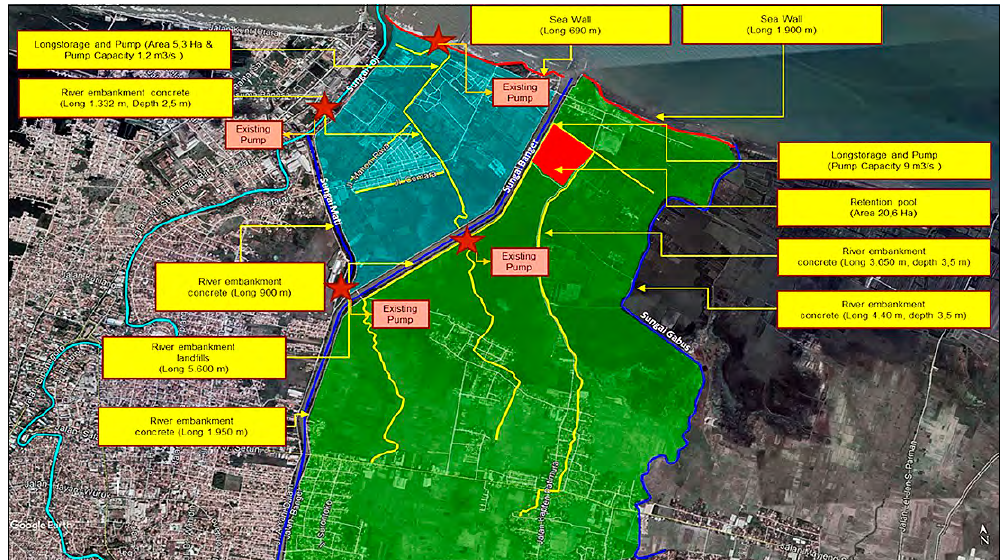
Figure 18. Design Concept (Alternative